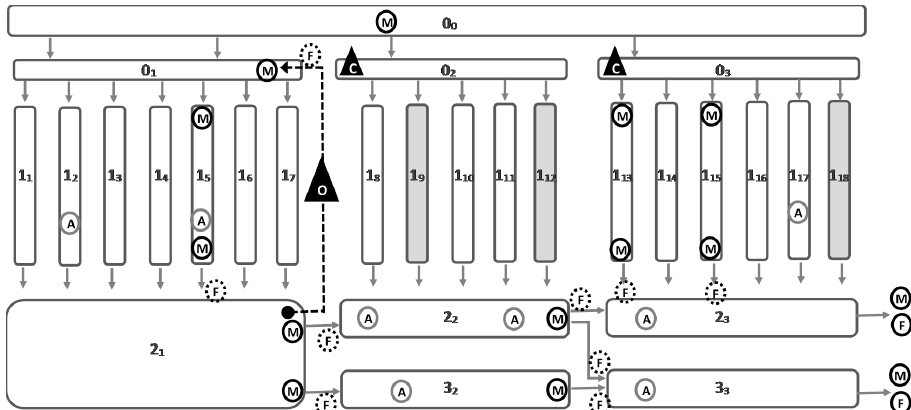
Figure 7. Fish farm general layout (A: paddle-wheel aerator, C: oxygen cone; O: high pressure oxygenator; M: physico-chemical monitoring location; F: water flow monitoring location). Some ponds (i.e., 1 9 , 1 12 and 1 18 ) were not stocked at the moment of monitoring, they are represented in grey. The figures 0, 1, 2 and 3 are theoretical numbers of water